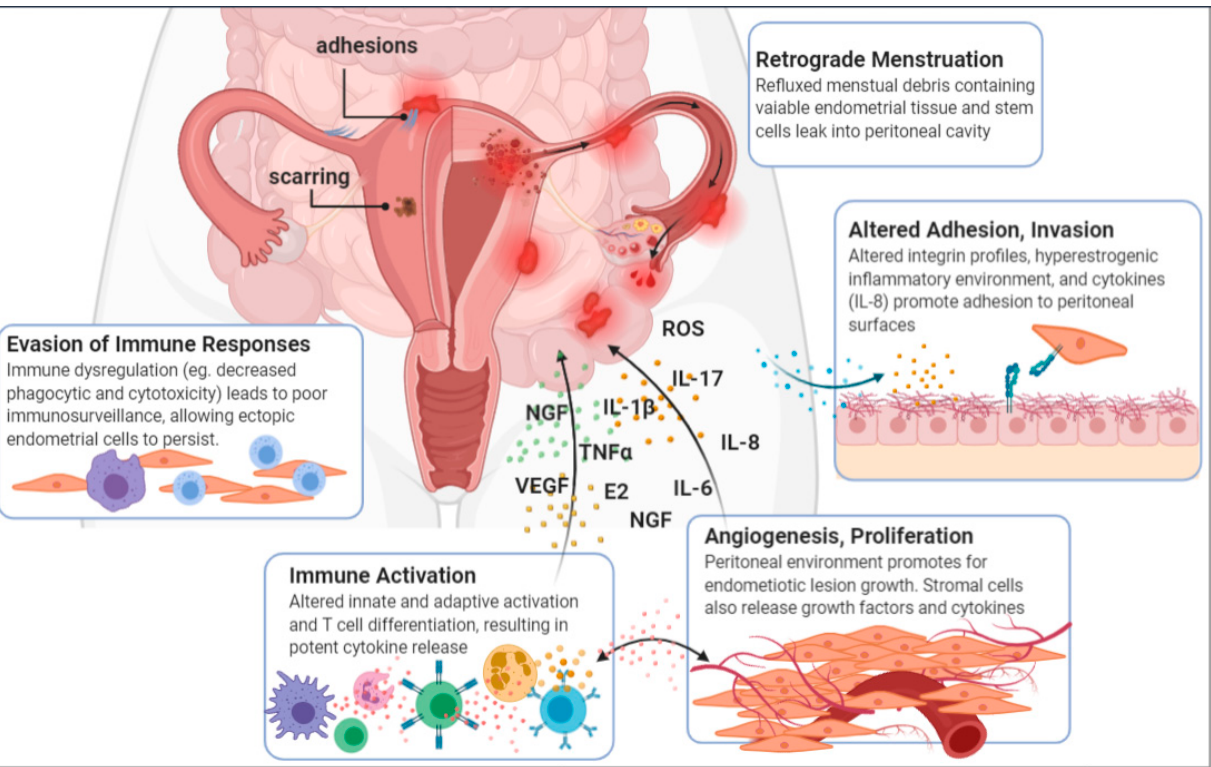
Figure 1. Aetiology and pathogenesis of endometriosis.